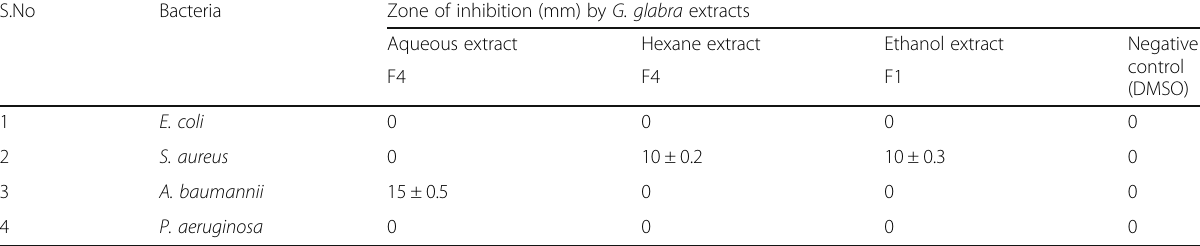
Table 1 Zone of inhibition showed by HPLC fractions of G. glabra